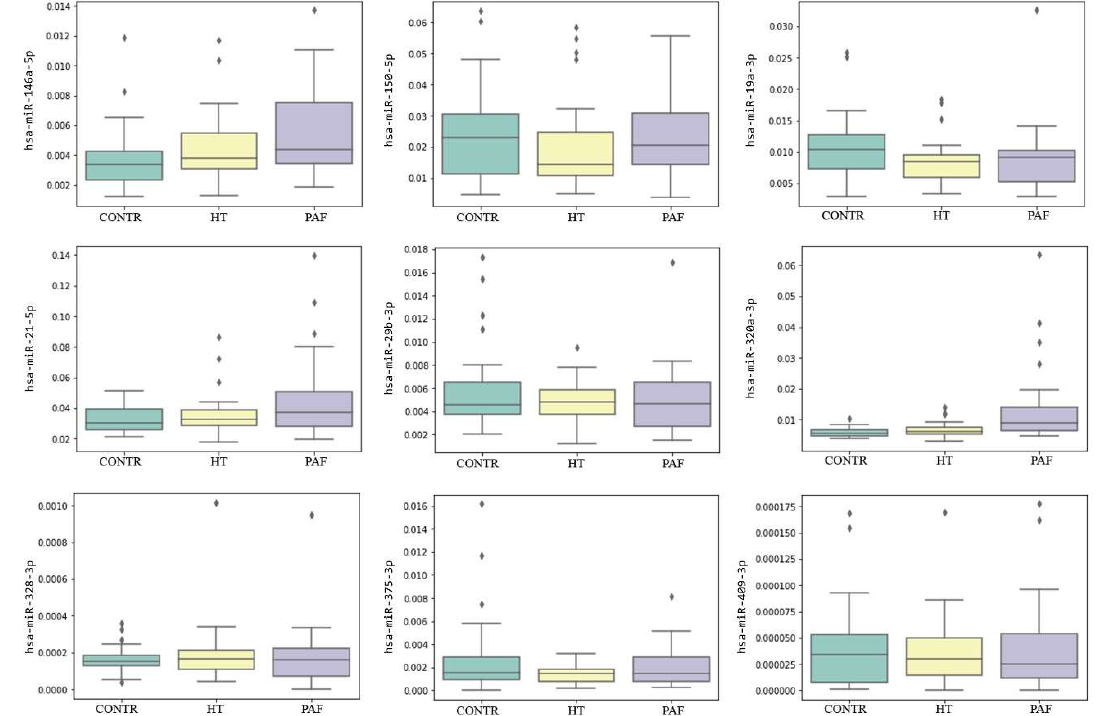
Figure 3. Relative miRNA plasma levels in the study sample groups: PAF: 30 PAF patients; HT: 30 hypertensive patients without AF; CONTR: 30 healthy controls. On the y-axis, the relative miRNA plasma levels (normalized to miR-16-5p) are shown. The boxplots represent the median and interquartile ranges (IQR) in the box, minimum and maximum values in the “whiskers”, and outliers in the rhombic dots.